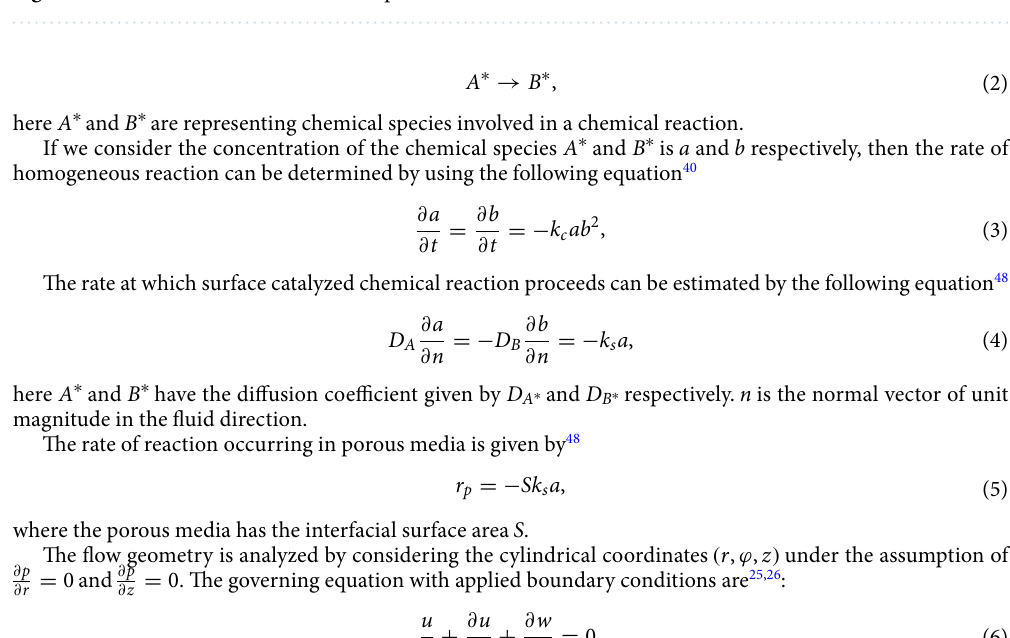
Figure 1. Geometrical sketch of the flow